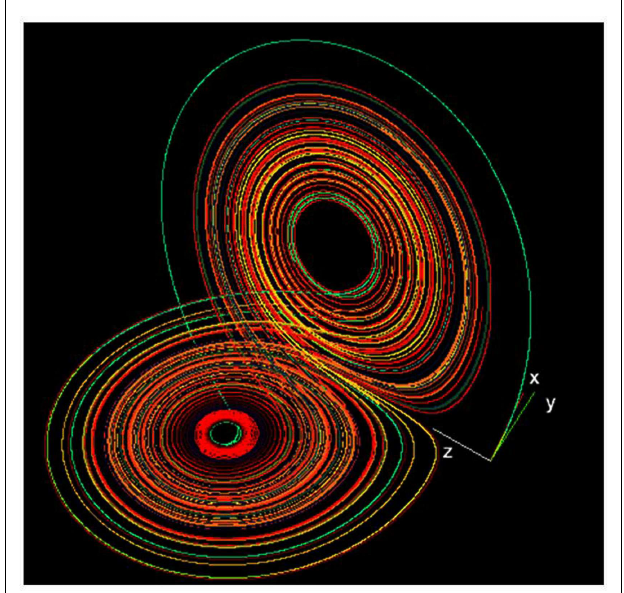
FIGURE 9 |The Lorenz strange attractor in its chaotic mode. Public source: http://en.wikipedia.org/wiki/Lorenz_system